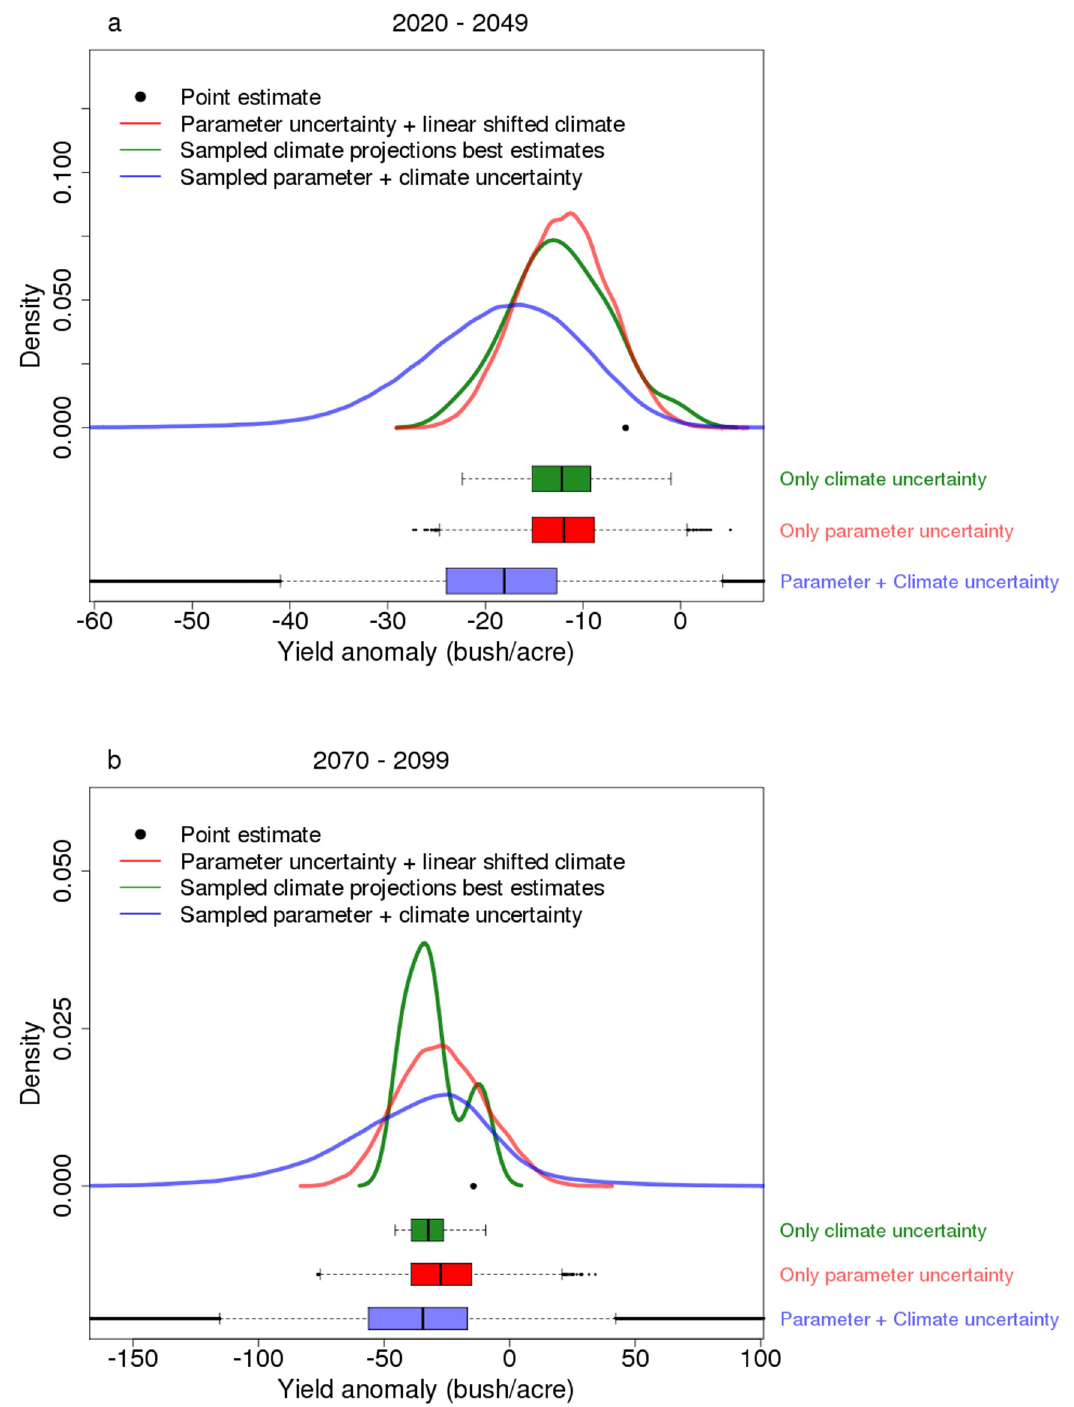
Fig 3. Marginal distributions of 30-year mean yield projections for different considerations of uncertainties. a: 2020–2049 b: 2070–2099 The point labels the point estimate without considering any uncertainty (the best estimate in a linear shifted climate projection); the three solid lines (red, green and blue) are the distributions when considering only parameter uncertainty, only climate forcing uncertainty and both uncertainty sources respectively. The distribution medians are labeled as vertical black lines on the box-whisker